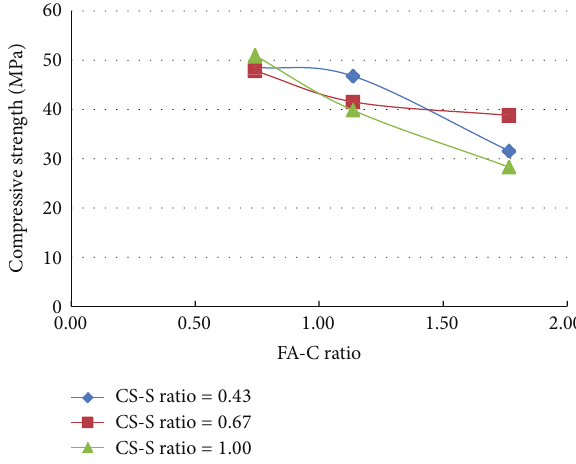
Figure 3: Compressive strength versus FA-C ratio (specimens S10– S18: with steel fibres).